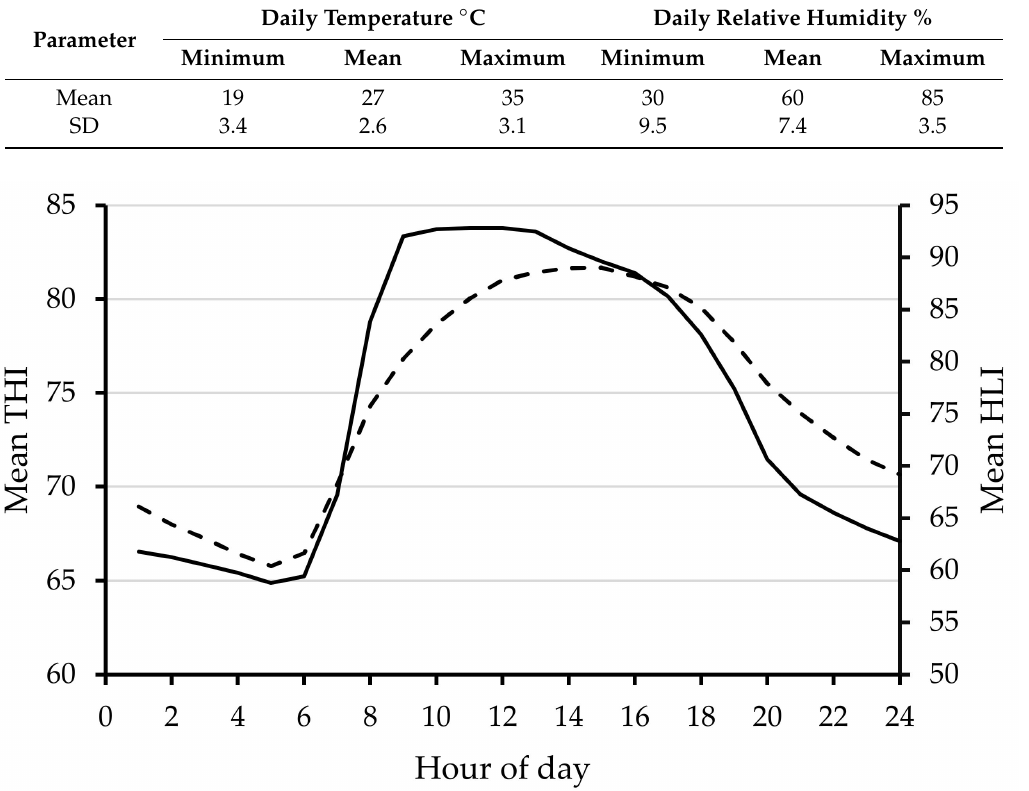
Figure 3. Mean hourly temperature humidity index (THI) ( broken line ) and heat load index (HLI) ( solid line ) values across 24 h for Experiment